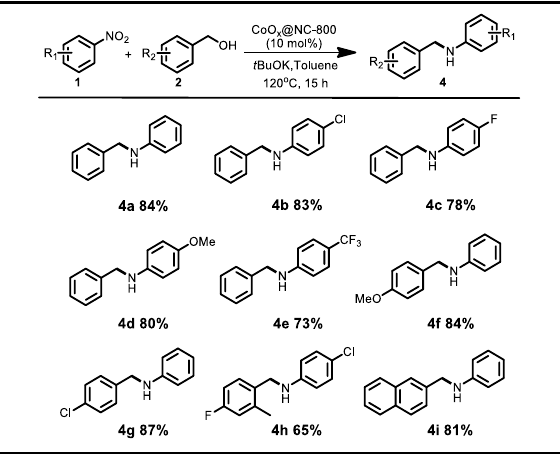
Table 3. Synthesis of amines from various alcohols and nitroarenes a .